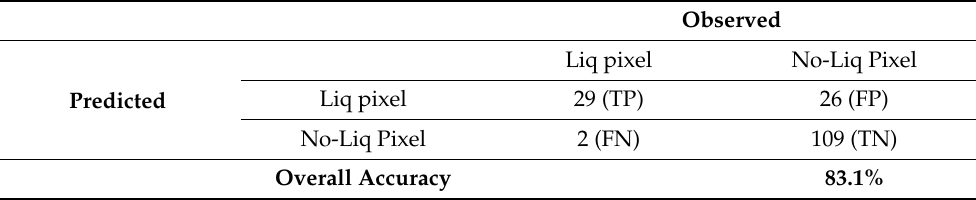
Table 4. Confusion matrix. TP = true positive; FP = False Positive; FN = False Negative; TN = True Negative.